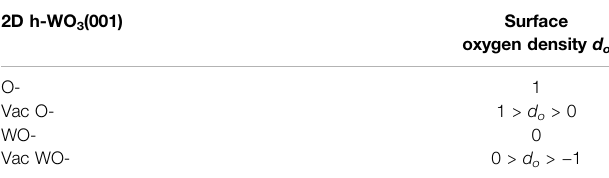
TABLE 3 | Relationship between microstructure, particle size, and gas sensitivity of H 2 , NH 3 , H 2 S, and NO 2 in h-WO 3 ( S is the detection scope, R is the responsiveness, and C is concentration).